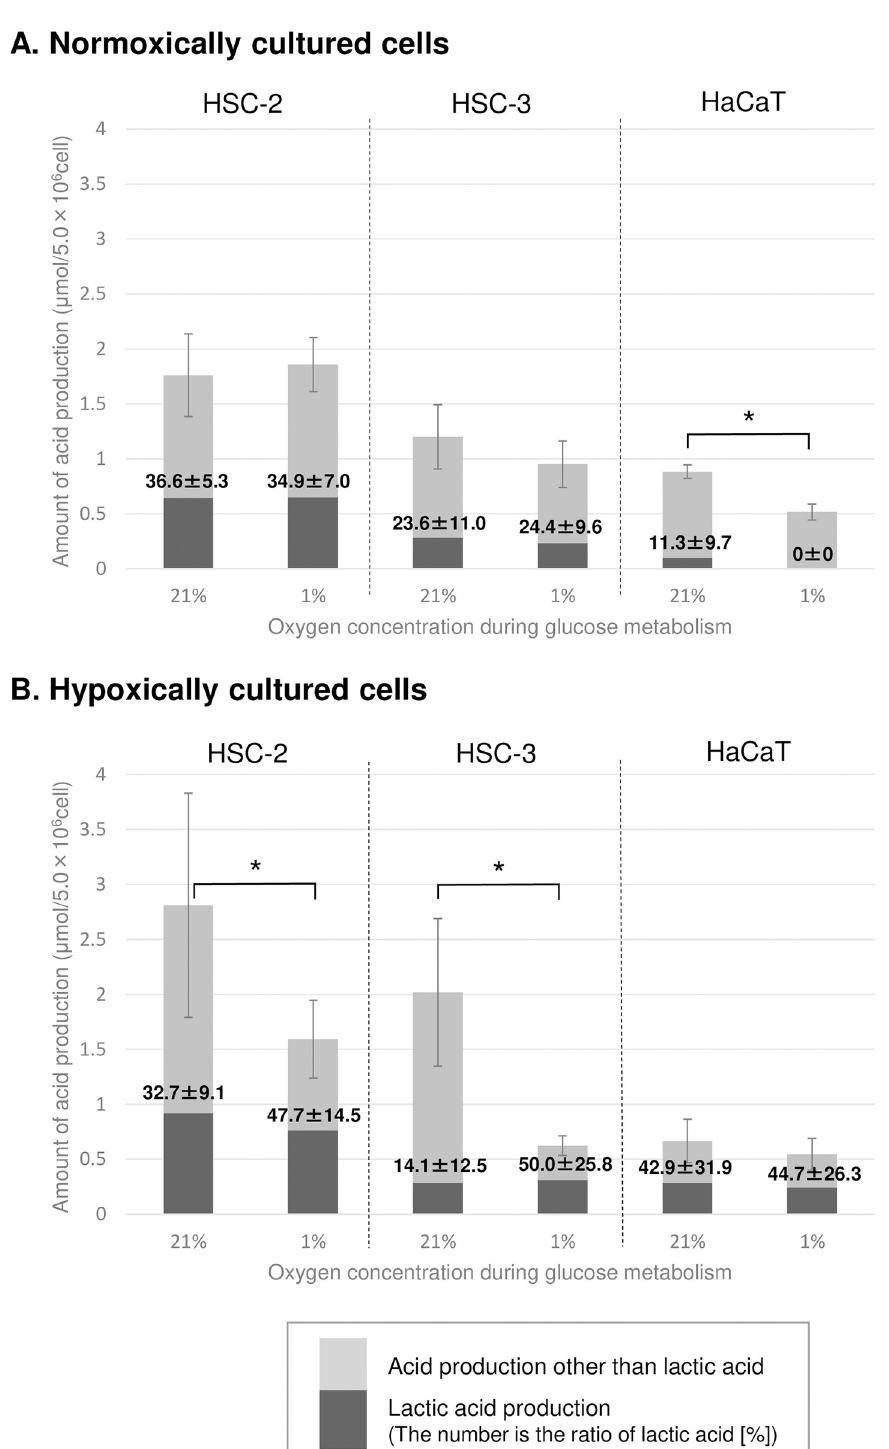
Fig 3. Production of lactic acid and other acids produced during glucose metabolism. The amount of other acids produced by (A) normoxically and (B) hypoxically cultured cells was calculated by subtracting the amount of lactic acid produced from total acid production, which was obtained from Fig 1. The error bars represent standard deviation. Significant difference ( � , p < 0.05) in the amount of acid other than lactic acid between normoxic and hypoxic conditions, according to the paired